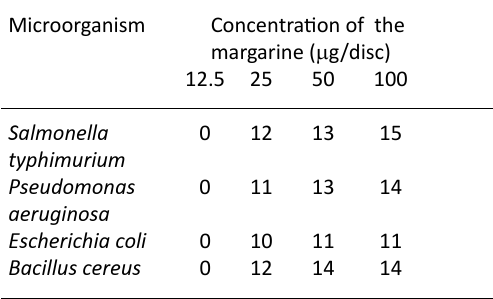
Table 2. Inhibition zoon (in mm) for different